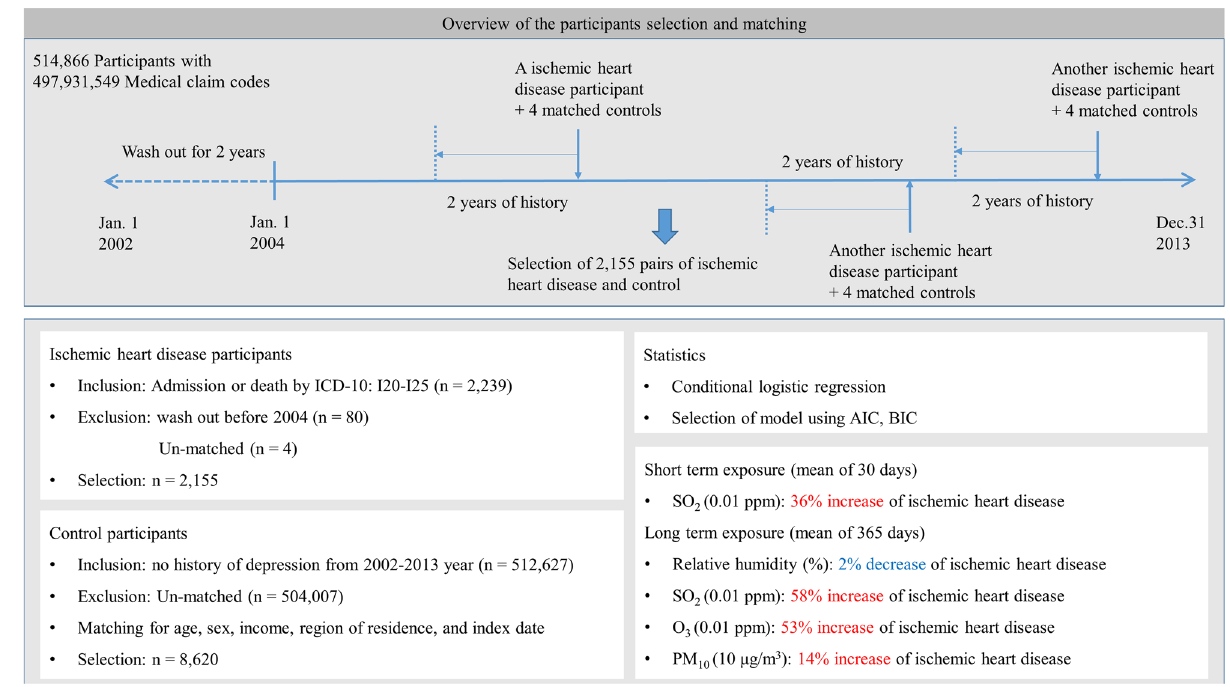
Figure 1. A schematic illustration of the participant selection process used in the present study. Of 1,125,691 participants, 2155 ischemic heart disease participants were matched with 8620 control participants for age, group, sex, income group, and region of residence. Then, ischemic heart disease patients and control participants were matched according to the meteorological data and air pollution data before the index